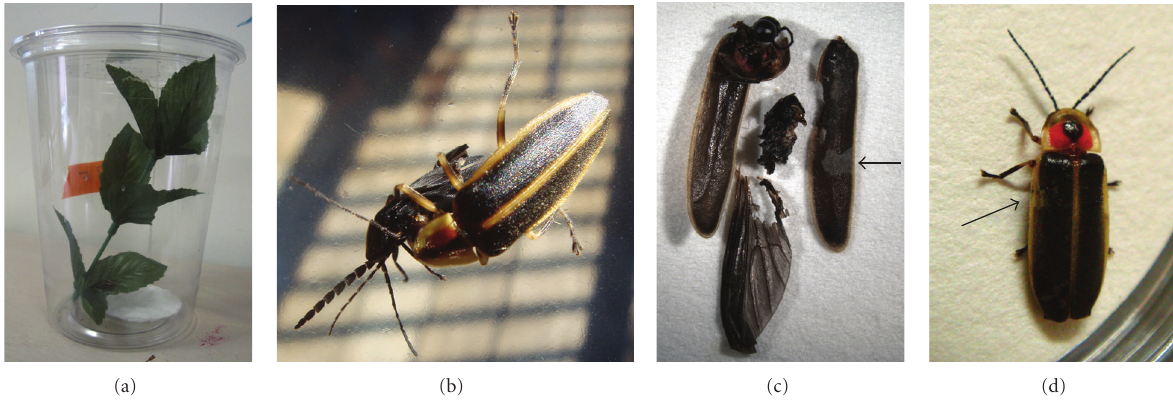
Figure 2: Laboratory tests of Photuris feeding preferences choice. (a) Trial setup with single Photuris spp. female in 1-quart container with artificial plant. (b) Female Photuris attacking an L. atra firefly. (c) Remnants of a male Photinus carolinus (arrow indicates dried hemolymph on the elytra). (d) A surviving male Photinus pyralis (arrow indicates puncture wound on left elytra).